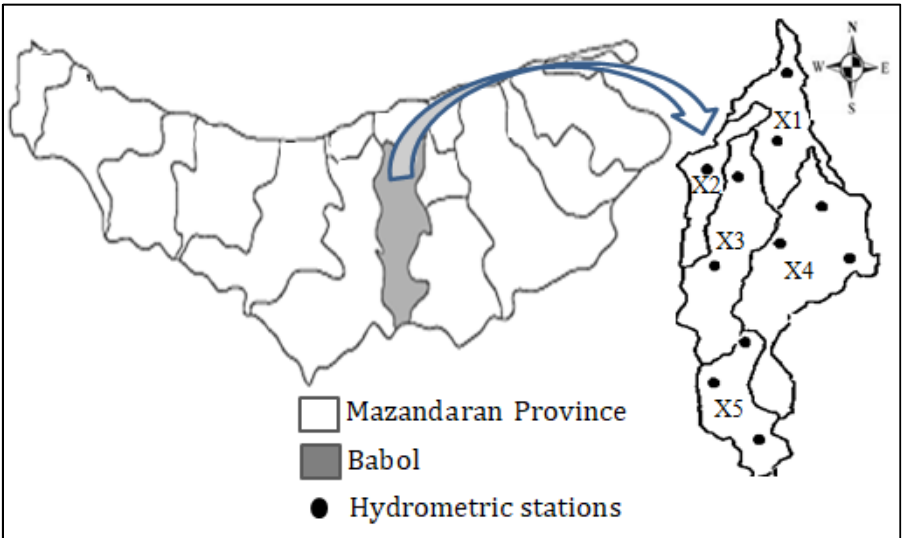
Figure 1. Location of the Babolroud watershed in Iran, Mazandaran Province.